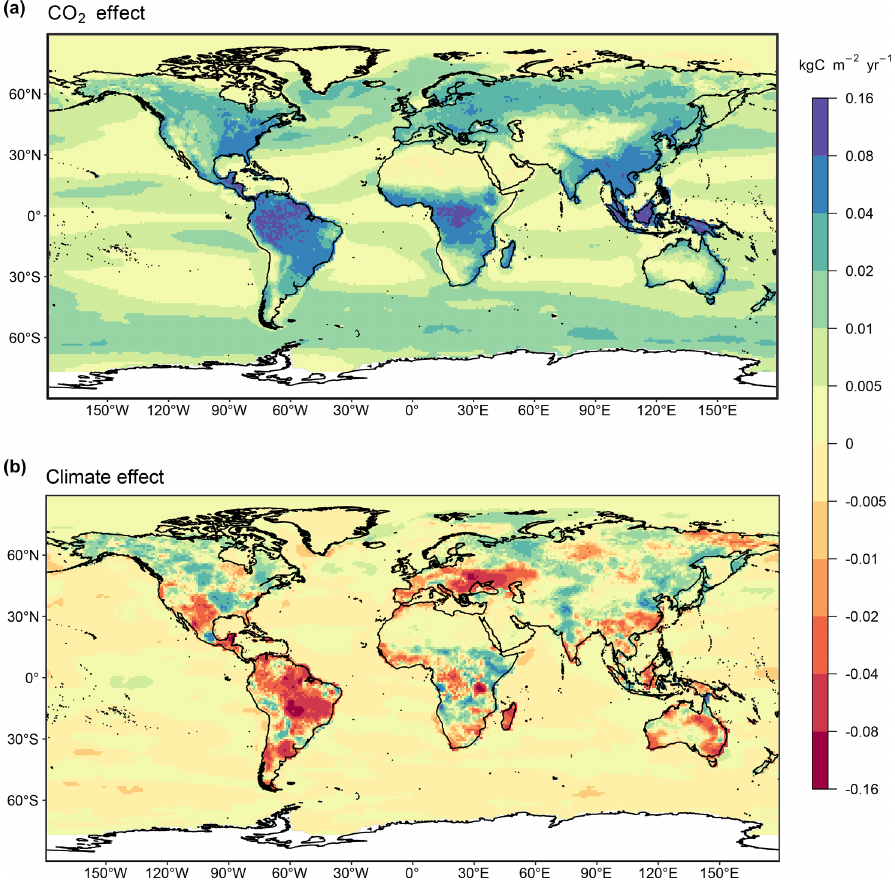
Figure 10. Attribution of the atmosphere–ocean ( S OCEAN ) and atmosphere–land ( S LAND ) CO 2 fluxes to (a) increasing atmospheric CO 2 concentrations and (b) changes in climate, averaged over the previous decade 2011–2020. All data shown are from the processed-based GOBMs and DGVMs. The sum of ocean CO 2 and climate effects will not equal the ocean sink shown in Fig. 6 which includes the f CO 2 - based data products. See Appendix Sects. C3.2 and C4.1 for attribution methodology. Units are in kgCm − 2 yr − 1 (note the non-linear colour